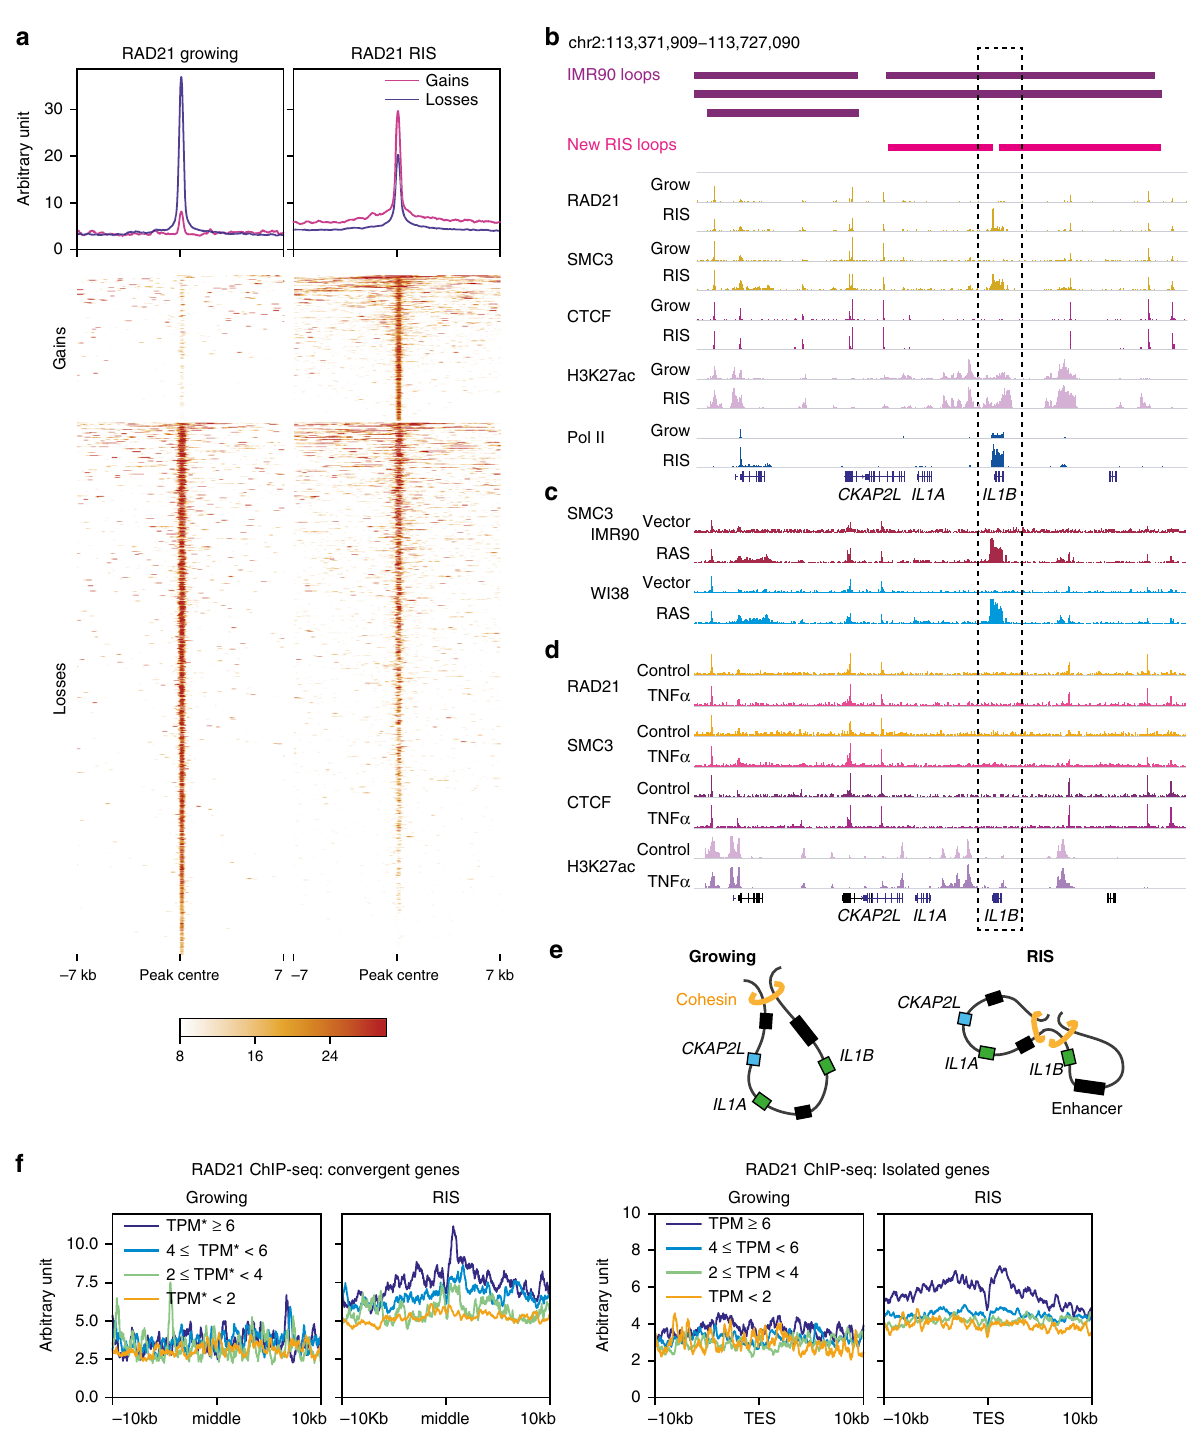
Fig. 4 De novo cohesin binding is associated with high gene expression during RIS. a Pro fi les and heatmaps of THOR-normalized differential RAD21 ChIP-seq signal in growing and RIS IMR90 cells. Differential signals ( ‘ Gains ’ or ‘ Losses ’ during RIS) were determined with THOR 62 at FDR 0.05. b Correlation between the inferred position of the new loop formation during RIS and indicated THOR-normalized ChIP-seq at the IL1 locus. c THOR- normalized SMC3 ChIP-seq signal at the IL1 locus in RIS IMR90 and WI38 cells, induced by constitutive expression of HRAS G12V . Grow, matched controls, which expressed control vector. d THOR-normalized ChIP-seq signal of cohesin (RAD21 and SMC3), CTCF and H3K27ac at the IL1 locus in TNF α -treated and matched control IMR90 cells. e Simpli fi ed model of new sub-loop formation within the loop encompassing the IL1A , IL1B and CKAP2L promoters, separating IL1B from IL1A and CKAP2L , along with their speci fi c enhancers. f Cohesin (THOR-normalized RAD21 ChIP-seq signal) distribution at the 3 ′ end of genes in RIS cells, grouped by log-transcripts-per-million (TPM) expression at convergent genes (overlapping extended 3 ′ ends) and isolated genes (no overlap with other genes). middle, middle points between the converging 3 ′ ends; TES, transcriptional end site. In the case of convergent genes, both genes in the pair were in the same expression